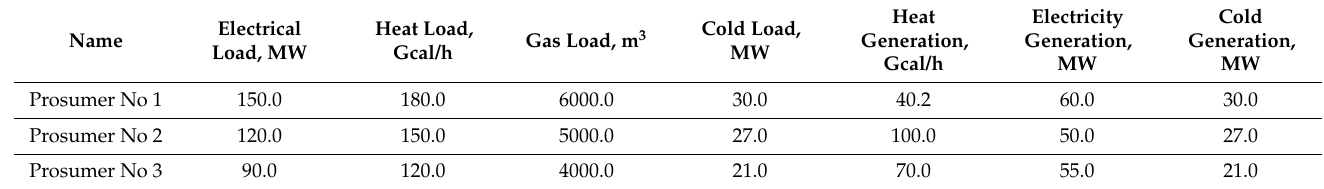
Table 3. Calculation results for network sections.